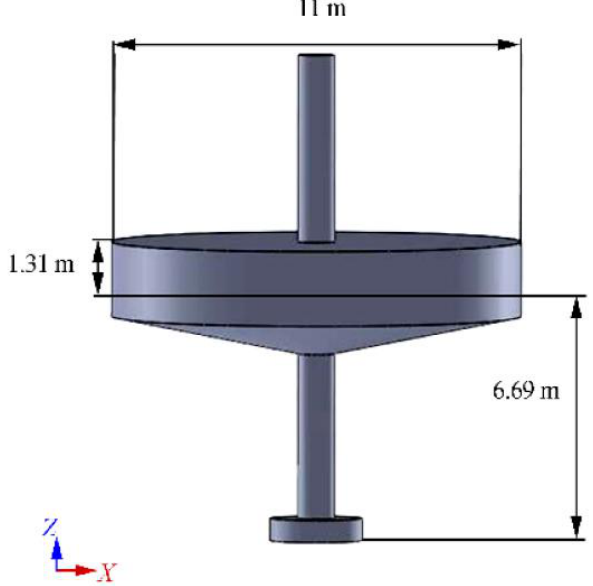
Figure 14. Optimized buoy shape to harvest more power [91] ..